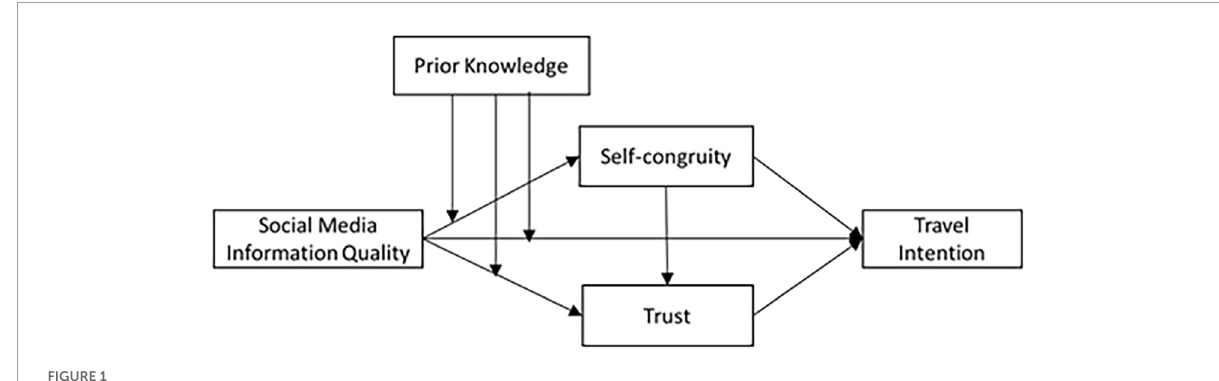
FIGURE1 Research model.